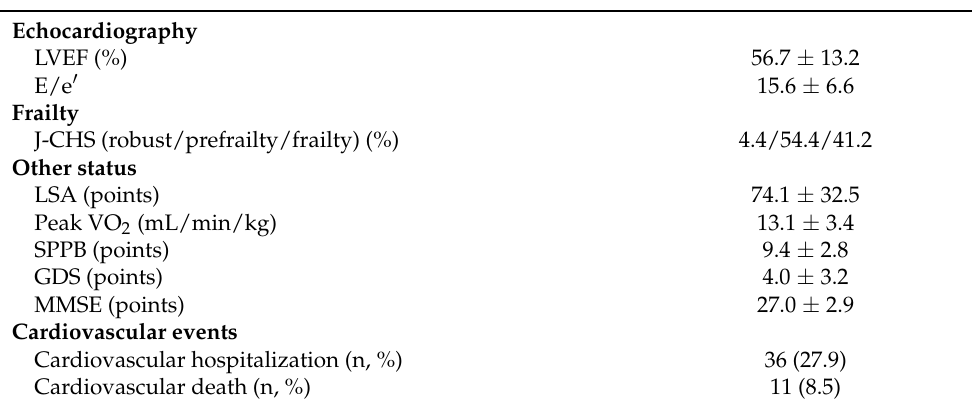
Table 2. Comparison of baseline clinical characteristics between the low and high LSA groups.